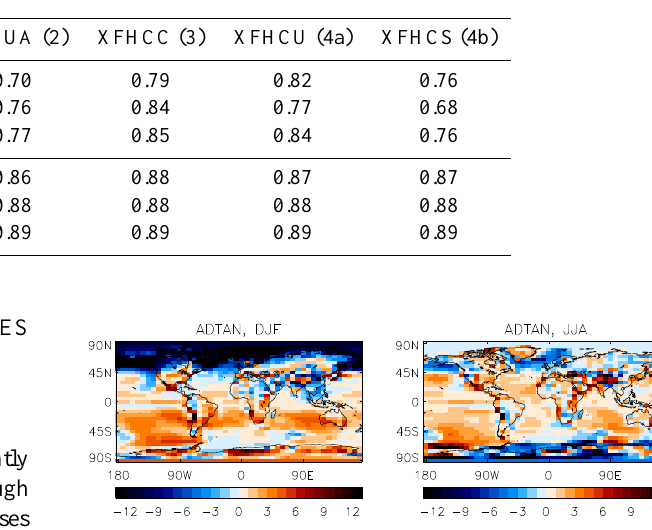
Table 5. Regional and seasonal AMS values for different members of the FAMOUS model hierarchy. These are calculated for 1.5m air temperature with respect to HadCM3. Generation numbers are given in brackets.